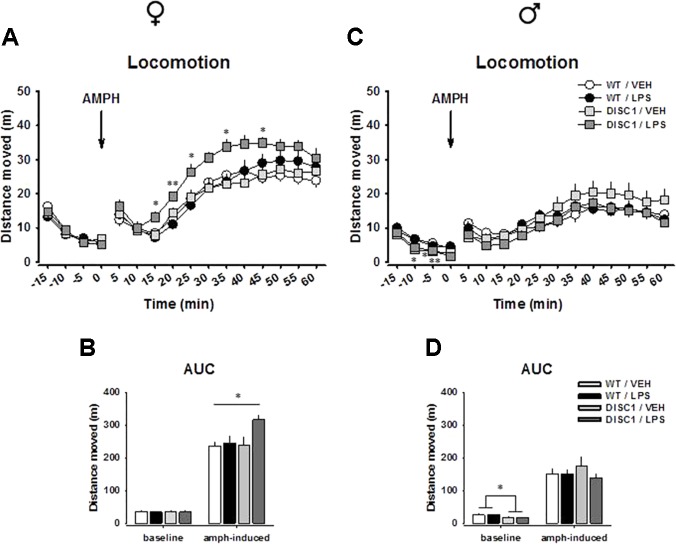
The effects of tgDISC1 with or without juvenile LPS administration on baseline and amphetamine-induced locomotor activity in adult female (left) and male rats (right). Baseline and amphetamine-induced locomotion are shown as activity at single time points for female (A) and male rats (C). Baseline and amphetamine-induced locomotion are shown as overall activity for female (B) and male rats (D). Arrow represents the amphetamine injection time, which is set to min 0. n = 6–10 per group. Amphetamine challenge dose = 1.5 mg/kg. Values are shown as mean ± SEM. *p < 0.05, **p < 0.01 compared to WT/VEH. WT, wild type; VEH, vehicle; LPS, lipopolysaccharide; AMPH, amphetamine; AUC, area under the curve.